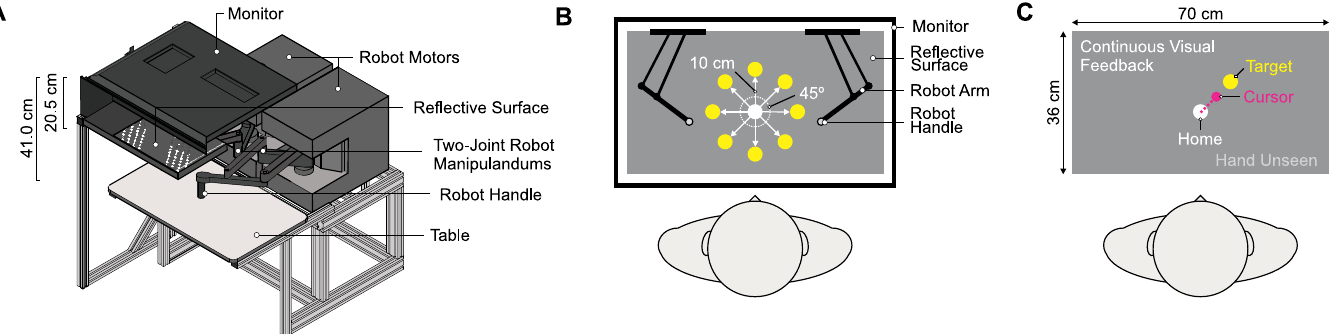
Fig 1. Experimental apparatus, dimensions and reaching environment. (A) Diagonal view of a cross-section of the experimental apparatus. Half of the monitor and reflective surface are displayed in order to show the right robot handle. (B) Visually guided reaching task. With full vision, participants reached from a central start position to one of eight peripheral targets (yellow circles) located 10 cm away from the start position (white circle) and distributed around the circumference of a circle (targets were separated by 45˚) (C) Example of continuous visual feedback of the cursor throughout each reaching trial.